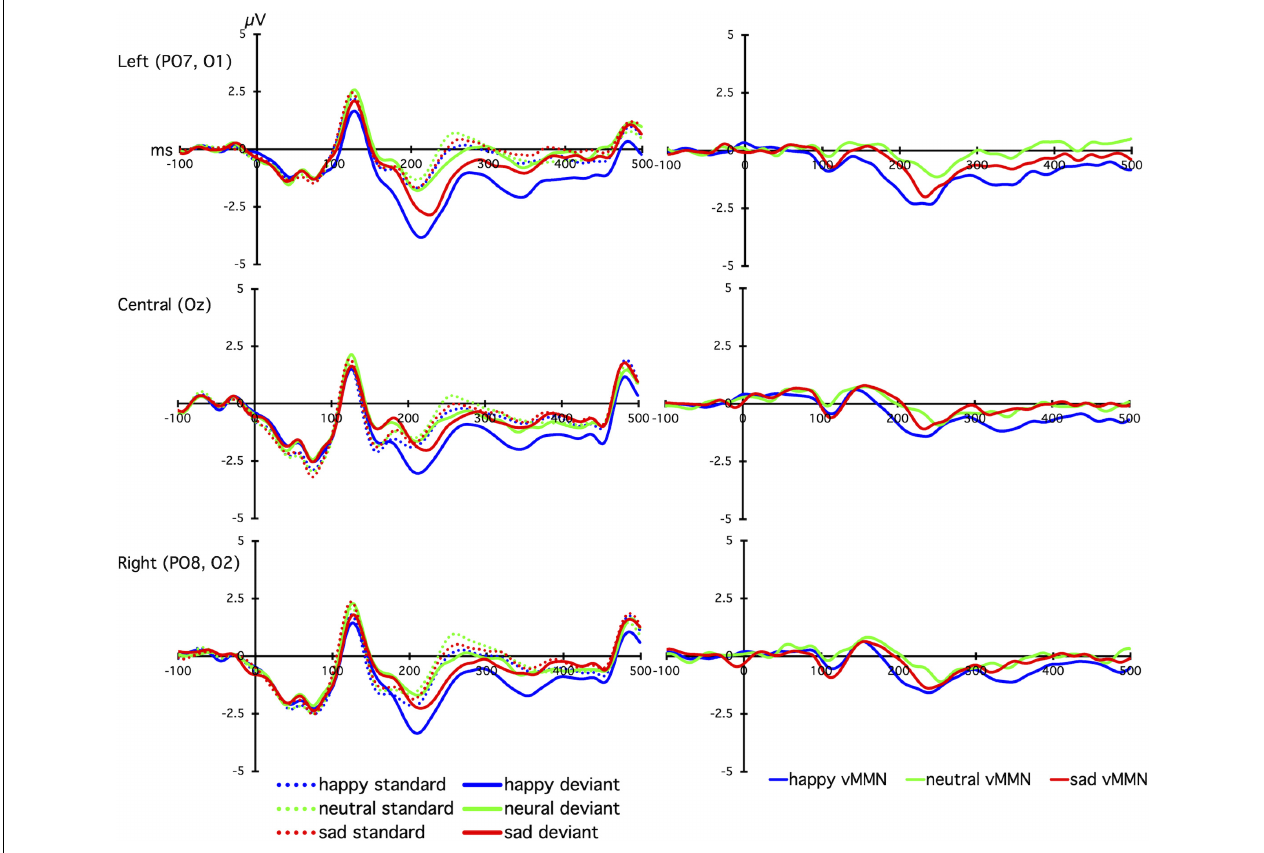
FIGURE 2 | The line graphs show the grand-averaged standard (dashed lines) and deviant (solid lines) event related potentials (left panel), and deviant-minus-standard difference waves (visual mismatch negativity; vMMN, right panel), for happy (blue), neutral (green), and sad (red) facial expressions. Plots show time (milliseconds; ms) on the x -axis, with 0 indicating stimulus onset of the emotional face, and voltage (microvolts; µ V) on the y -axis, with positive voltages plotted